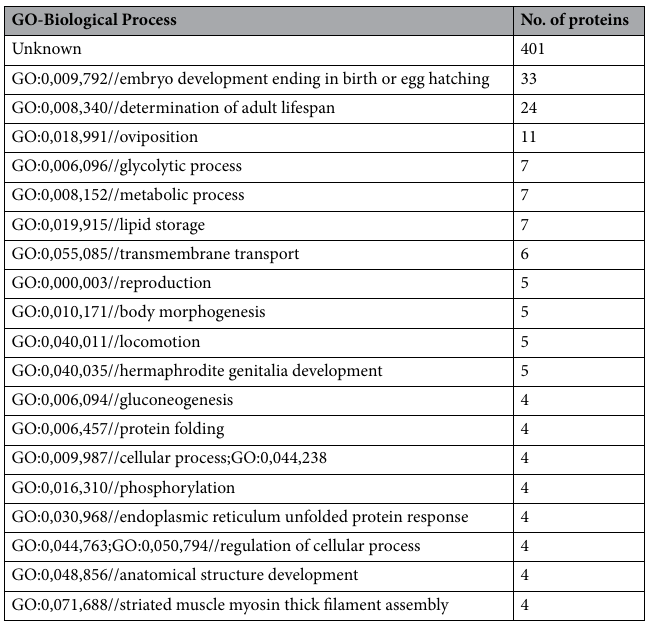
Table 2. List of top-20 proteins classified by Gene Ontology (GO) according to the biological processes involved in